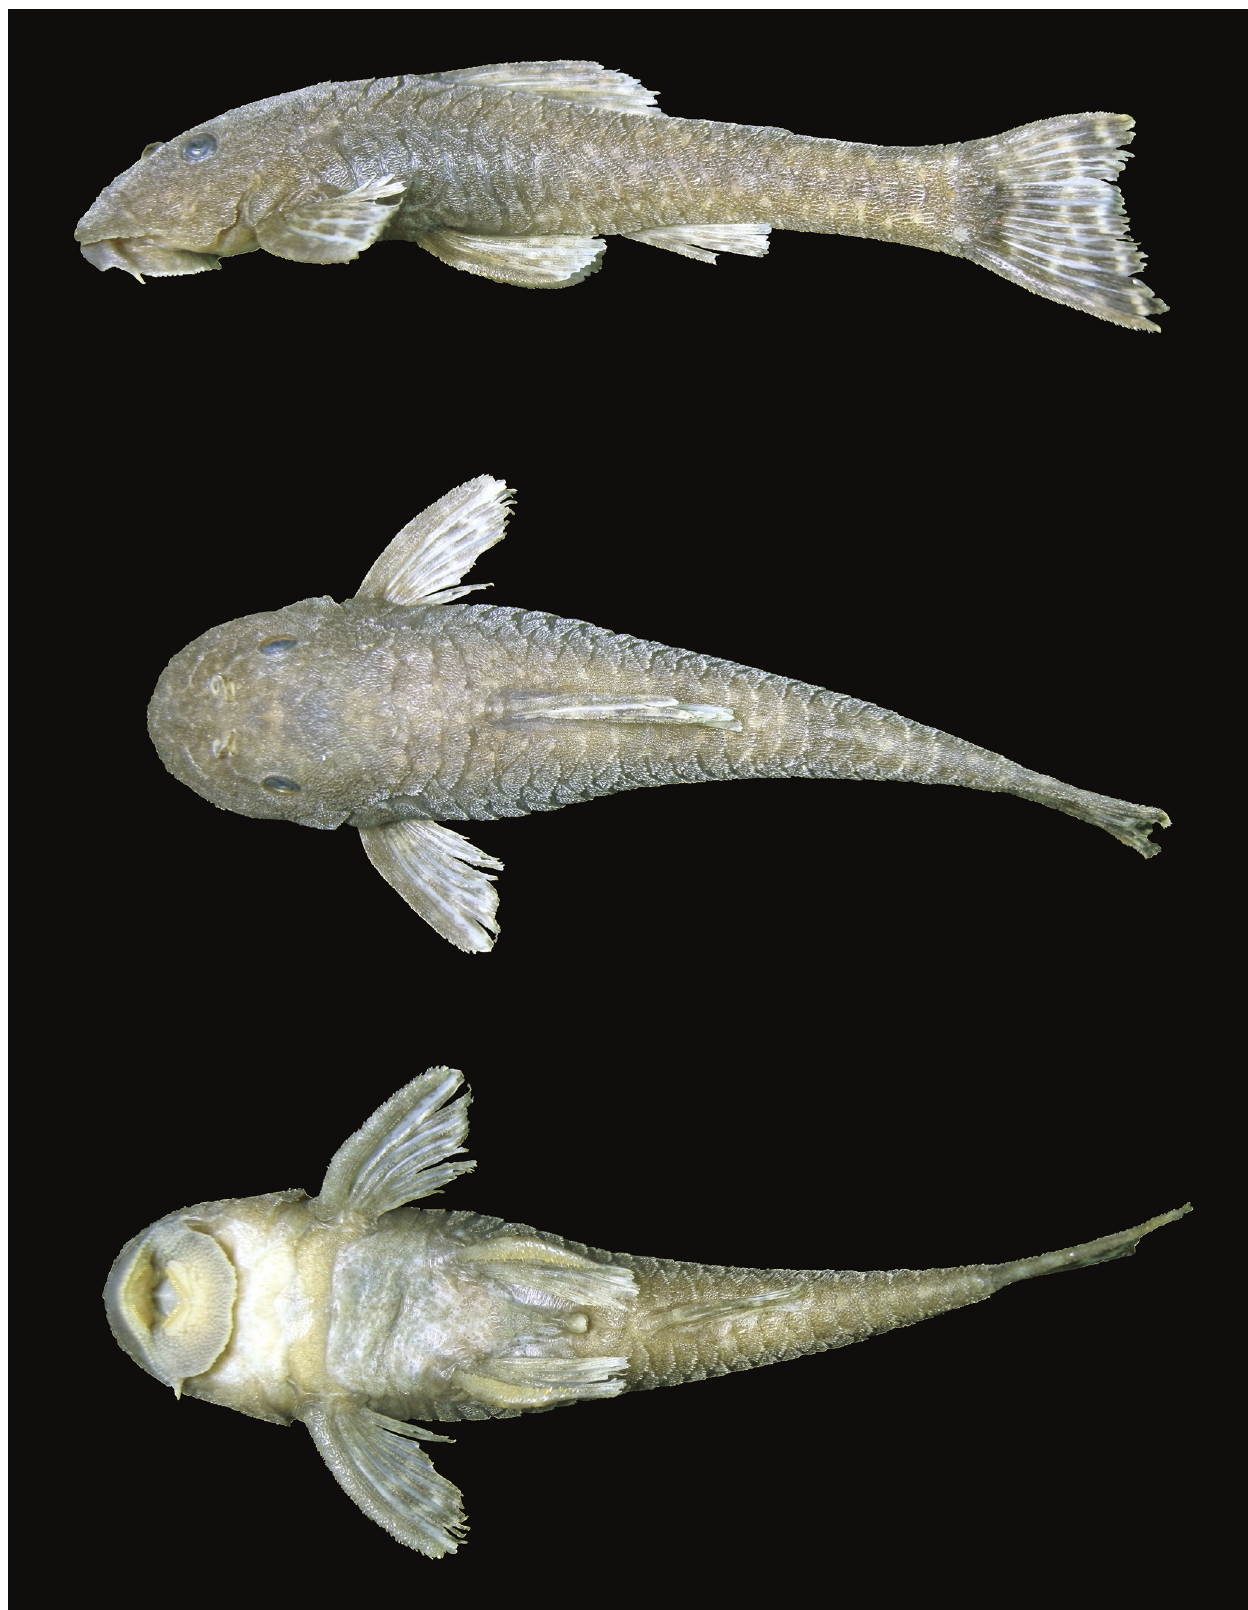
Fig. 2. Lateral, dorsal, and ventral views of Parotocinclus spilurus , topotype UFRN 1255, 37.2 mm SL, female; Brazil, Ceará State, Icó Municipality, rio Salgado, rio Jaguaribe